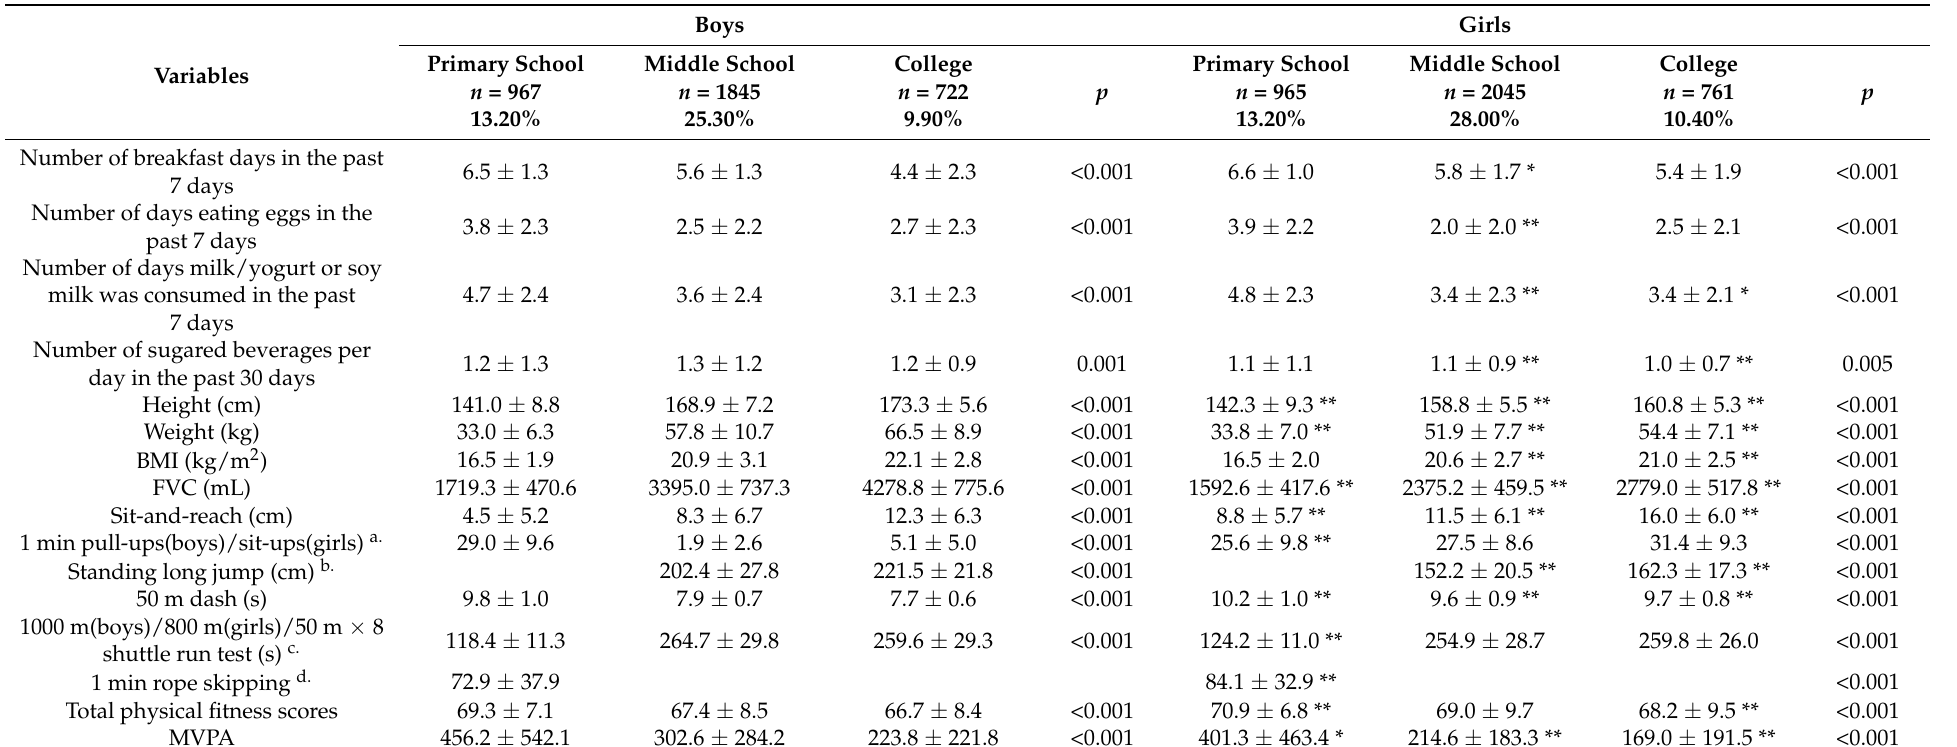
Table 2. Sample descriptive data according to the school